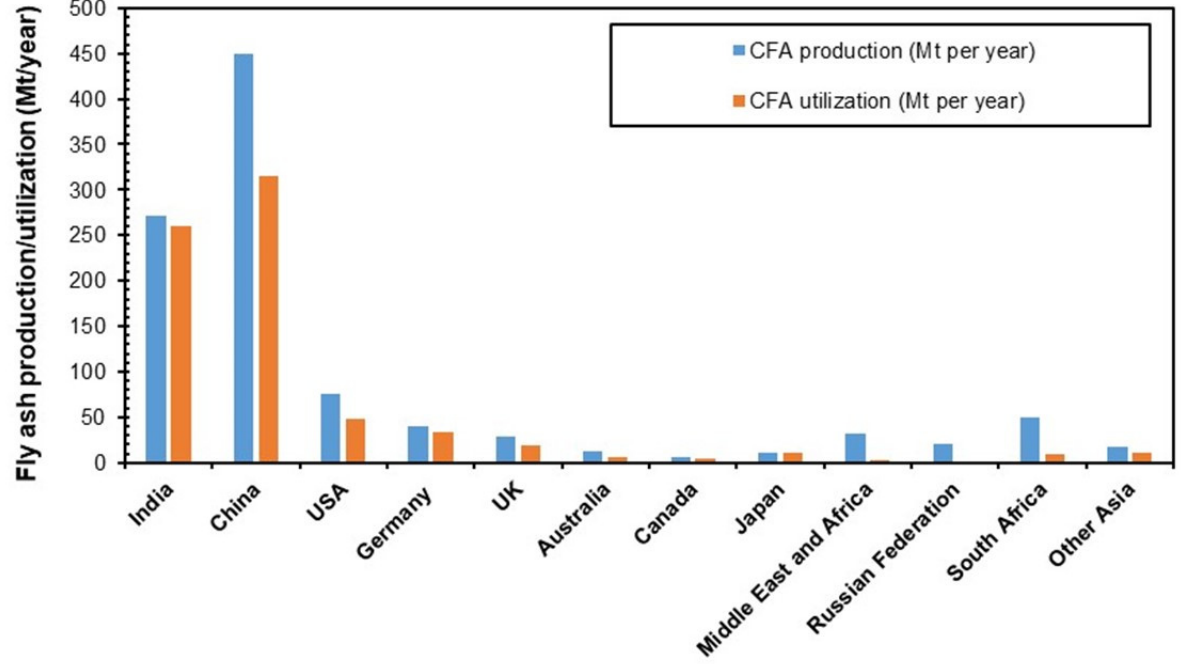
Figure 8. Production and utilization of coal fly ash [122–126].